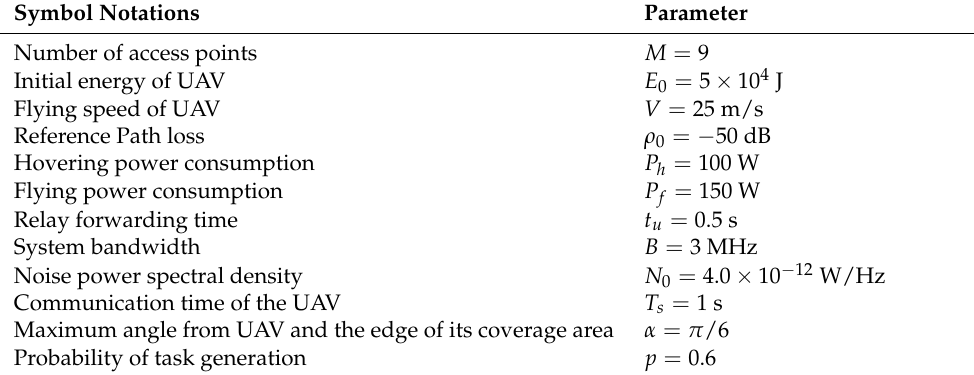
Table 2. Simulation